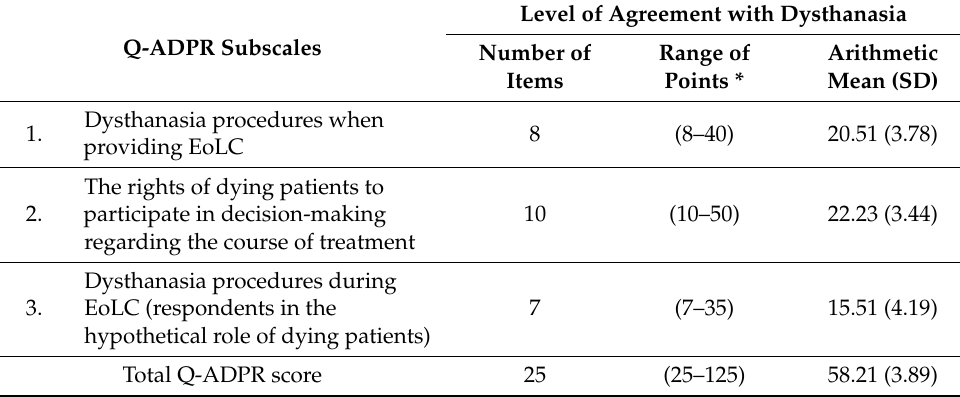
Table 2. Nurses’ level of agreement with dysthanasia (n =